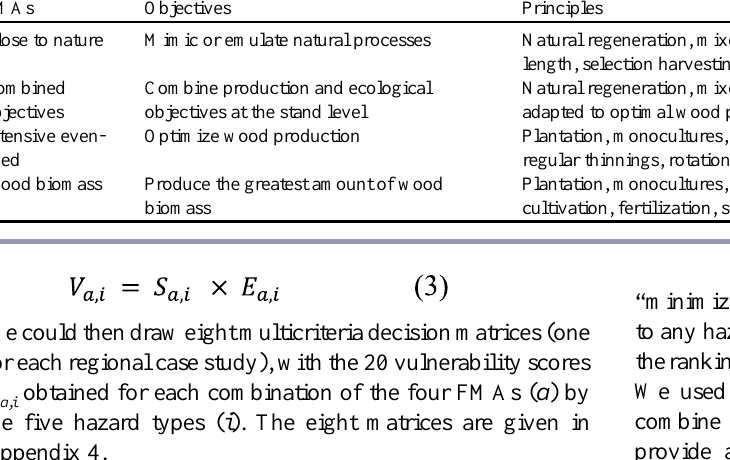
Table 4. Main objectives and basic principles of the four forest management alternatives compared in the MCRA FMAs Objectives Close to